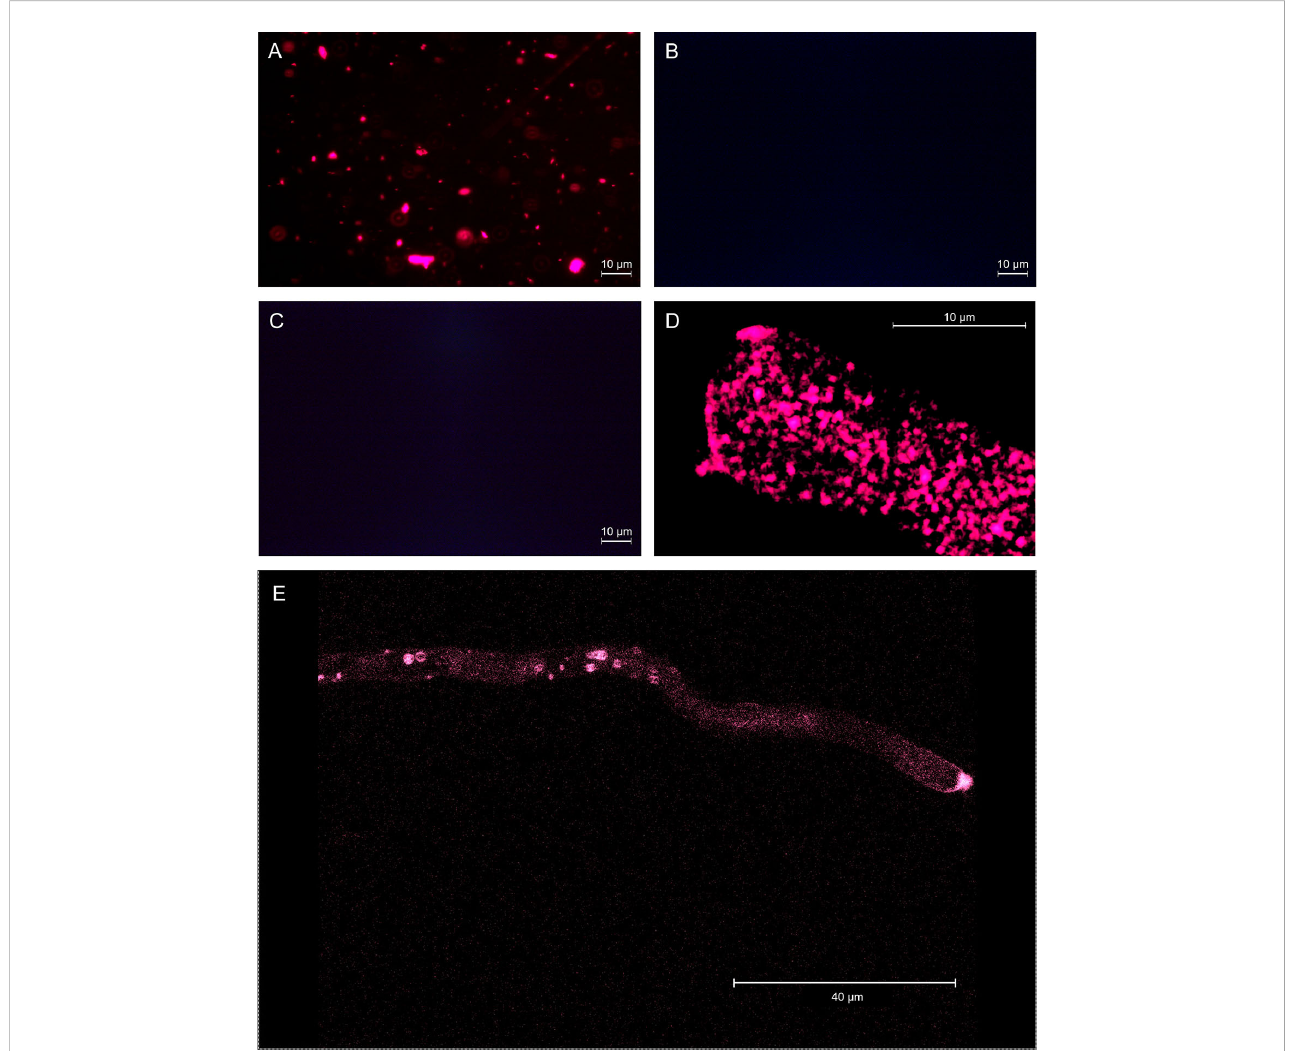
FIGURE 3 EVs from germinated kiwi pollen (A) , EVs from kiwi pollen hydrated in a humid chamber (B) , and EVs from kiwi pollen hydrated in PBS (C) , dyed with FM4-64 ™ to enhance the presence of double-layered vesicles. (D, E) show FM4-64 ™ staining on the pollen tube apical region at different magni fi cations, as a positive